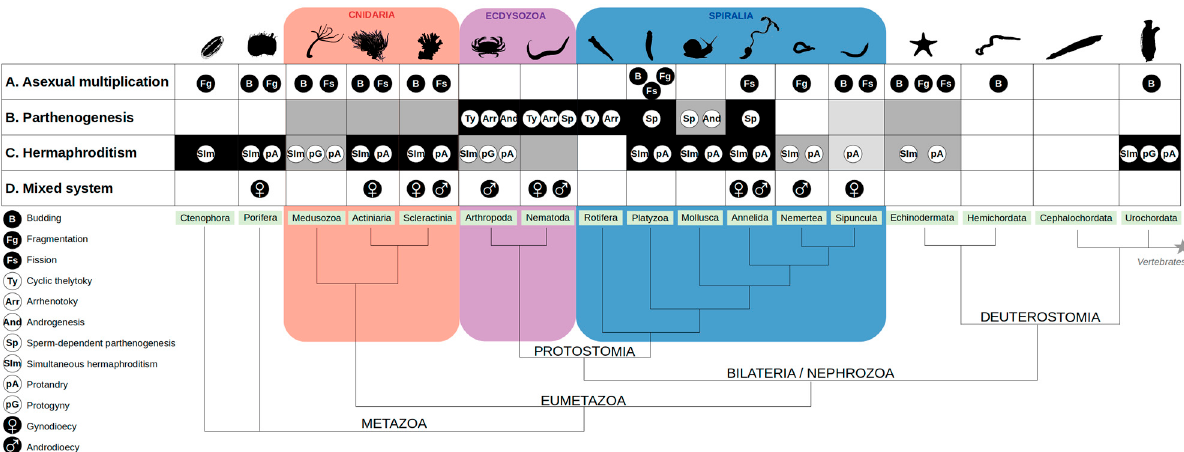
Figure 1. Modes of reproduction among invertebrates. ( A ): Asexual reproduction can occur by budding “B”, where part of the parent develops into a full organism before being split up; fragmentation “Fg”, where the offspring develops from a fragment of the parent; fission “Fs”, where an individual splits into two separate and identical organisms [1,18]. ( B ): Occurrence of parthenogenesis (frequent in black, rare in grey, or absent in white). The light grey for Sipuncula corresponds to a punctual description in only one species: Themiste Lageniformis [30]. Different types of parthenogenesis can be observed: cyclic thelytoky “Ty”; arrhenotoky “Arr”; sperm-dependent parthenogenesis “Sp” (gynogenesis or hybridogenesis); androgenesis “And” [29,31,32]. Although parthenogenesis was described in several Cnidaria species, little is known about the underlying mechanisms [33,34]. ( C ): occurrence of hermaphroditism: frequent (black), rare (grey) or absent (white) [1,31,35]. The light grey for Sipuncula corresponds to a punctual description in only few species [36]. Hermaphroditism can be simultaneous “Sim” or sequential: usually taking the form of protandry “pA” (first male and then female), with protogyny “pG” (first sex as female) reported only in Hydra [18], Urochordata [31] and in few crustaceans [37]. ( D ): Gynodioecy, with females “ ♀ ” coexisting with hermaphrodites, is only punctually observed (2 species of Porifera, 3 species of Actinaria, 1 Scleractinia, 1 Annelida, 1 Sipuncula, and 2 species of Nematoda). By contrast, androdioecy, with males “ ♂ ” coexisting with hermaphrodites, was observed in more than 70 species of Arthropoda and almost 30 species of Nematoda [38,39].